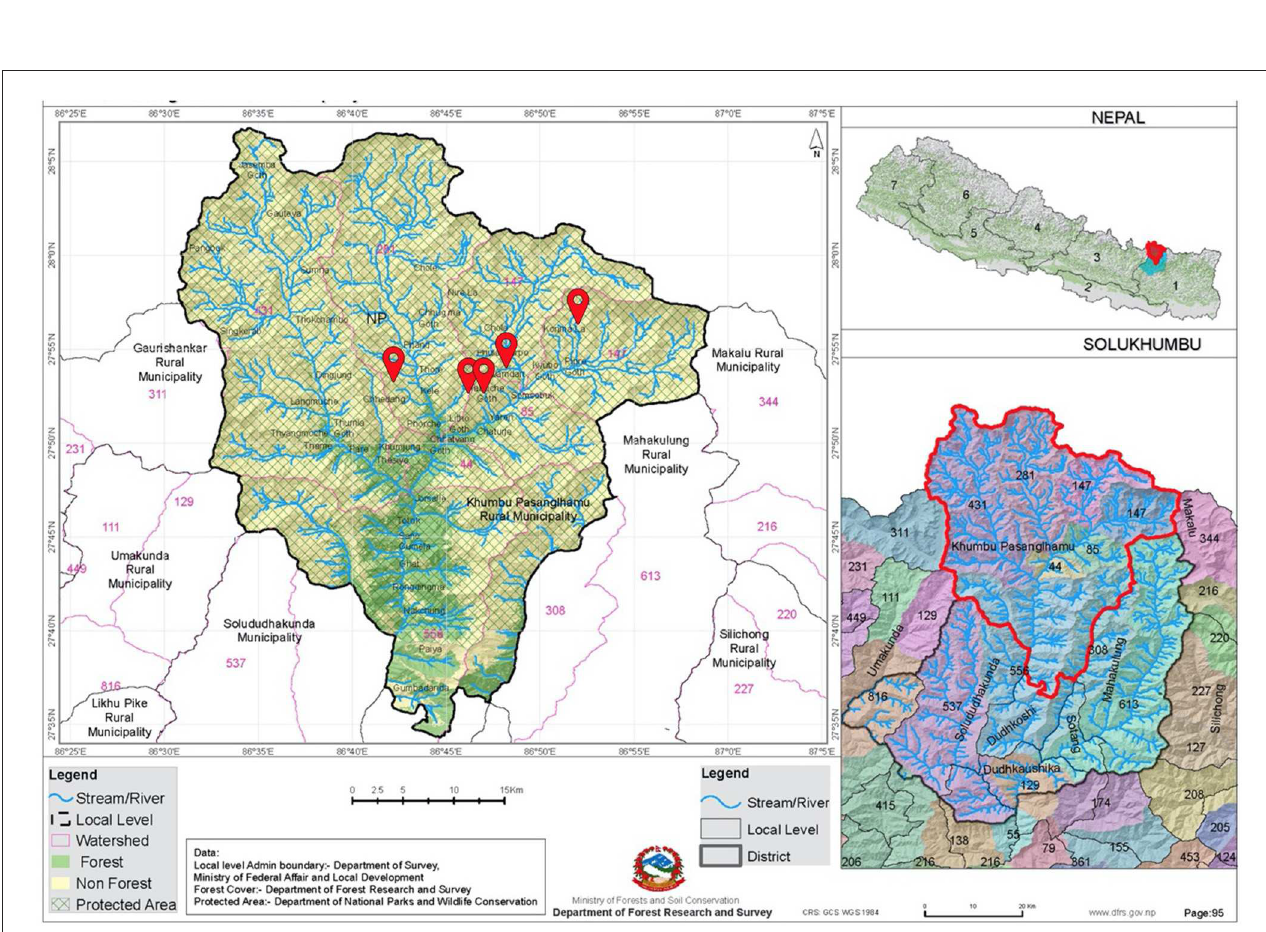
FIGURE2 Map of Khumbu Pasang Lhamu Rural Municipality showing study sites with red markers [Department of Forest Research and Survey (DFRS), 2018].